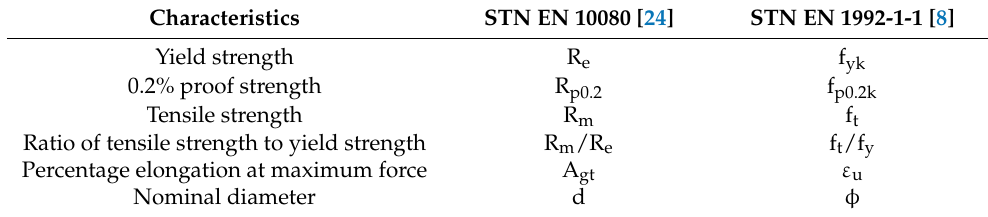
Table 1. Comparison of the quantities used in STN EN 10080 to those used in EN 1992-1-1. Characteristics